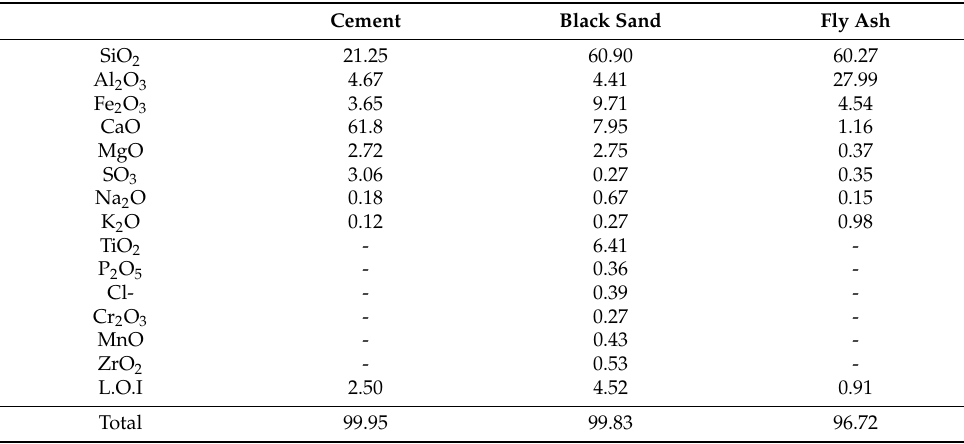
Table 1. Oxide composition of binder materials and black sand, wt% [41].